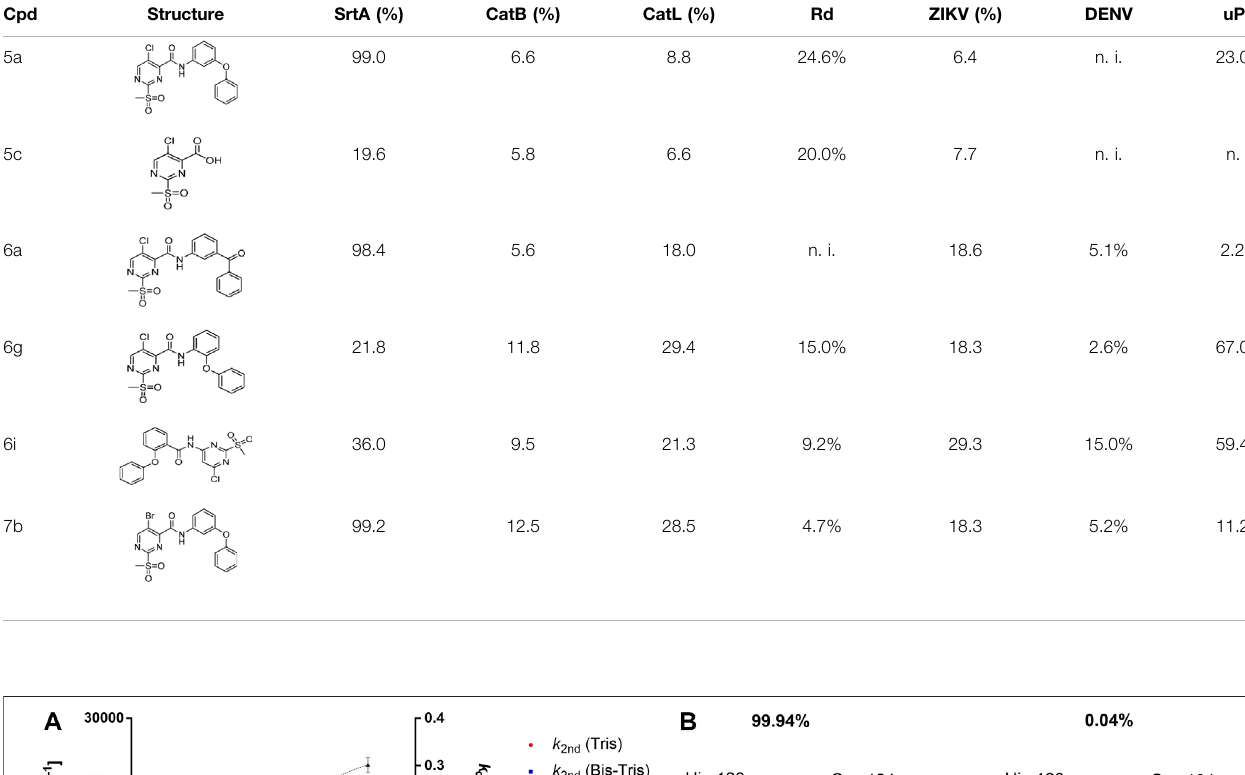
TABLE 4 | Protease inhibition selectivity of a representative compound set. Compounds were tested at a fi nal concentration of 100 µM inhibitor. The inhibition is expressed relative to the DMSO control in (%); n. i. (cid:1) no inhibition at 100 µM. Cpd Structure